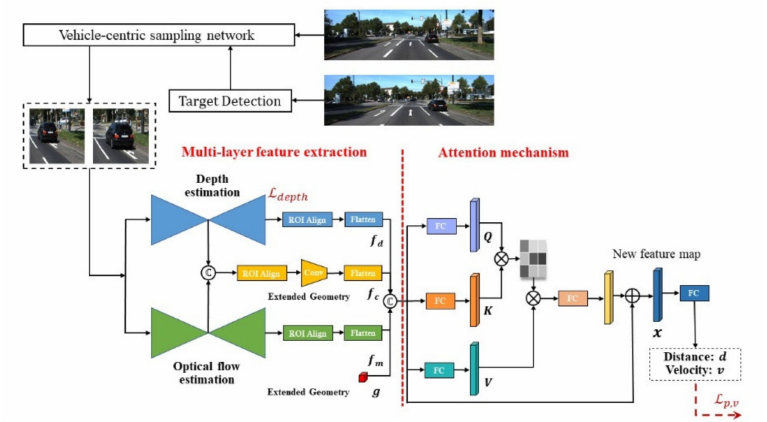
Figure 2. Algorithm flowchart. The target detection part is used to extract the vehicle detection frame in the video and input it into the speed measurement and ranging network. The algorithm used for target detection is the general Yolo3 [44]